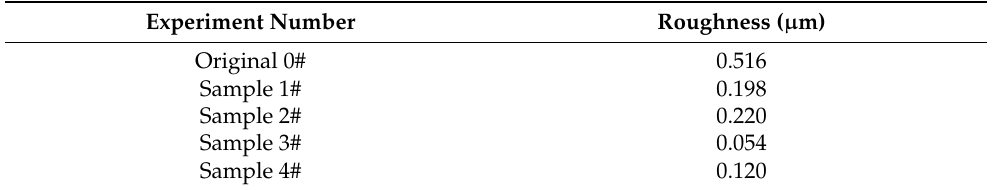
Table 2. Surface roughness Ra values.